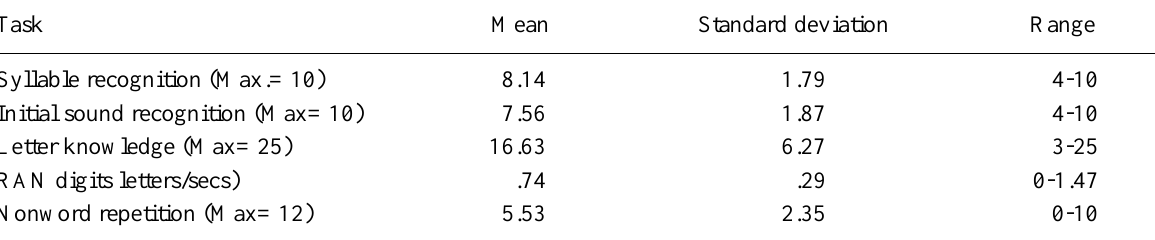
Descriptive Statistics for the whole Sample at the Beginning of the Year Task